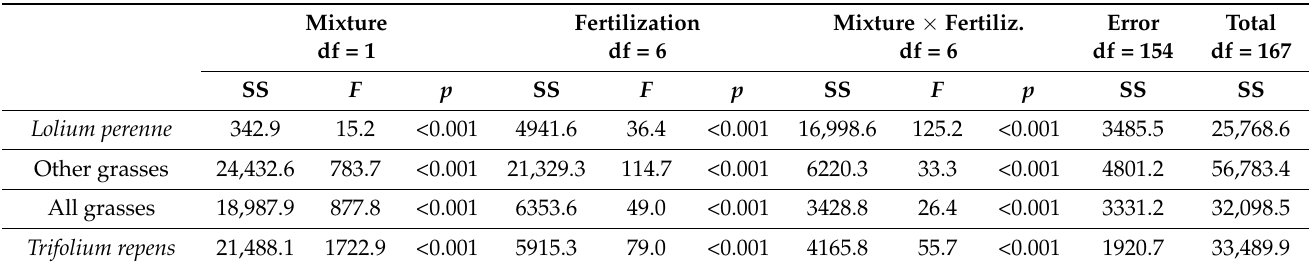
Table 1. Two-way ANOVA analyses of influence of fertilization and plant mixture on share of analyzed components in sward ( n =